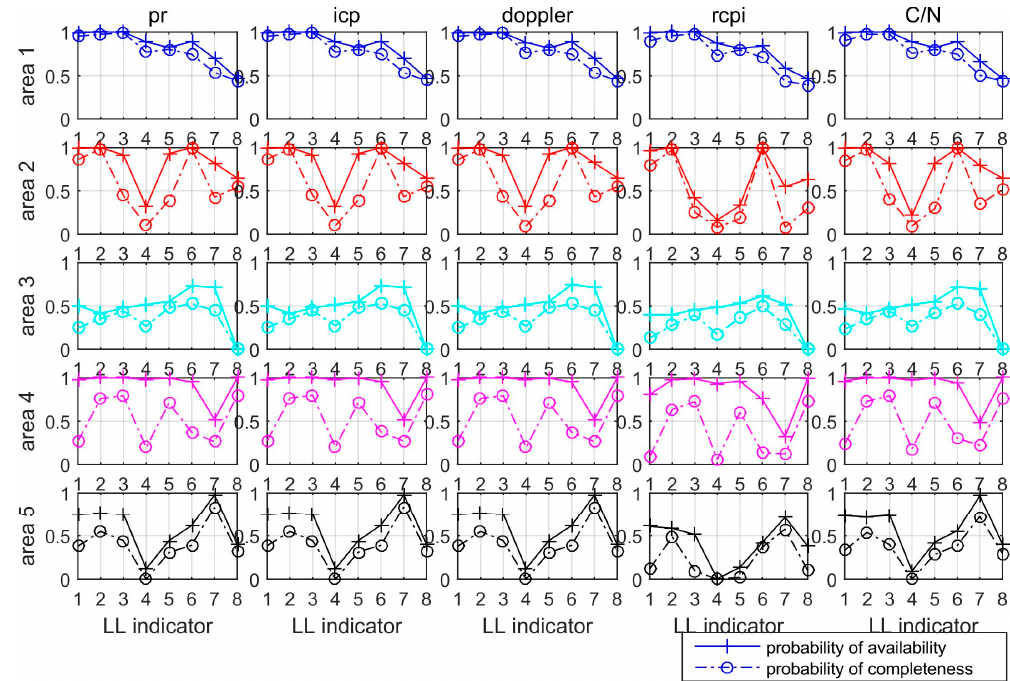
Figure 7. Probability of available measurements for each area for each LocataLites (LL).